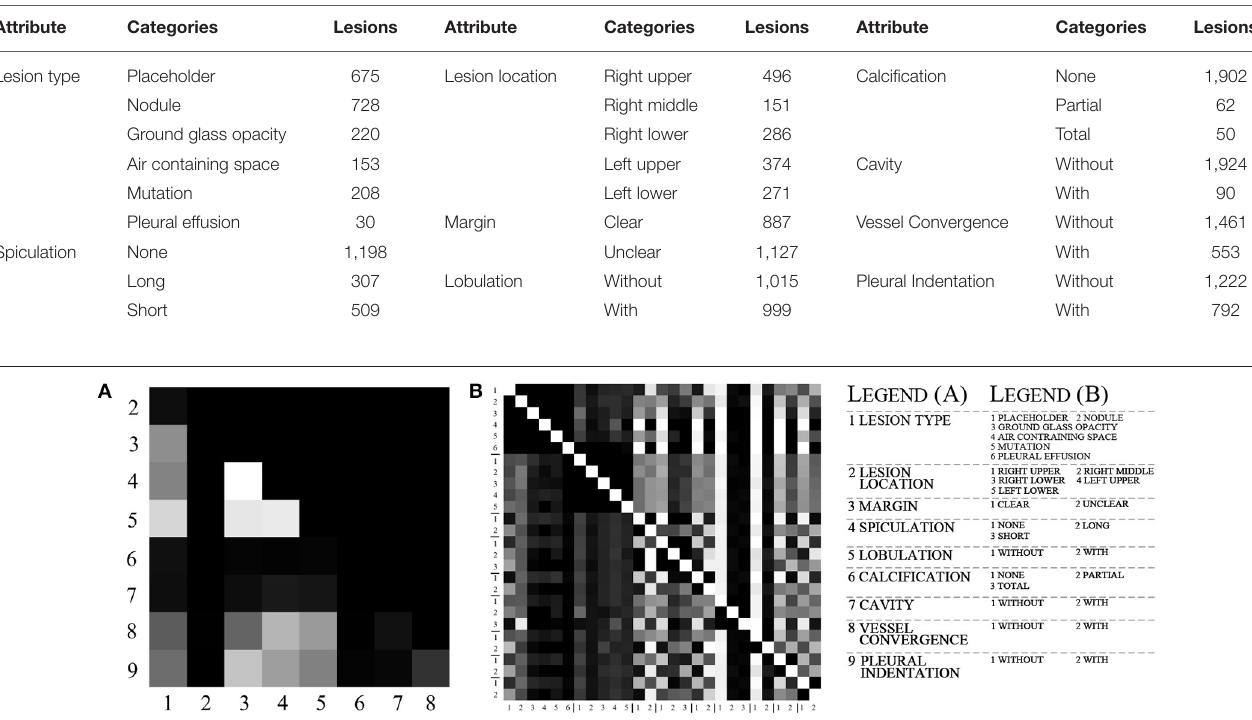
FIGURE 2 | The visualization of chi-test and conditional probabilities. (A) is the visualization of the chi-test result. (B) is the visualization of conditional probabilities. The brighter grid means that the attributes indicated by its row and column numbers are more relevant. For (A) , the meaning of labels 1–9 is listed in legend, and for (B) , the legend lists the meaning of label in each